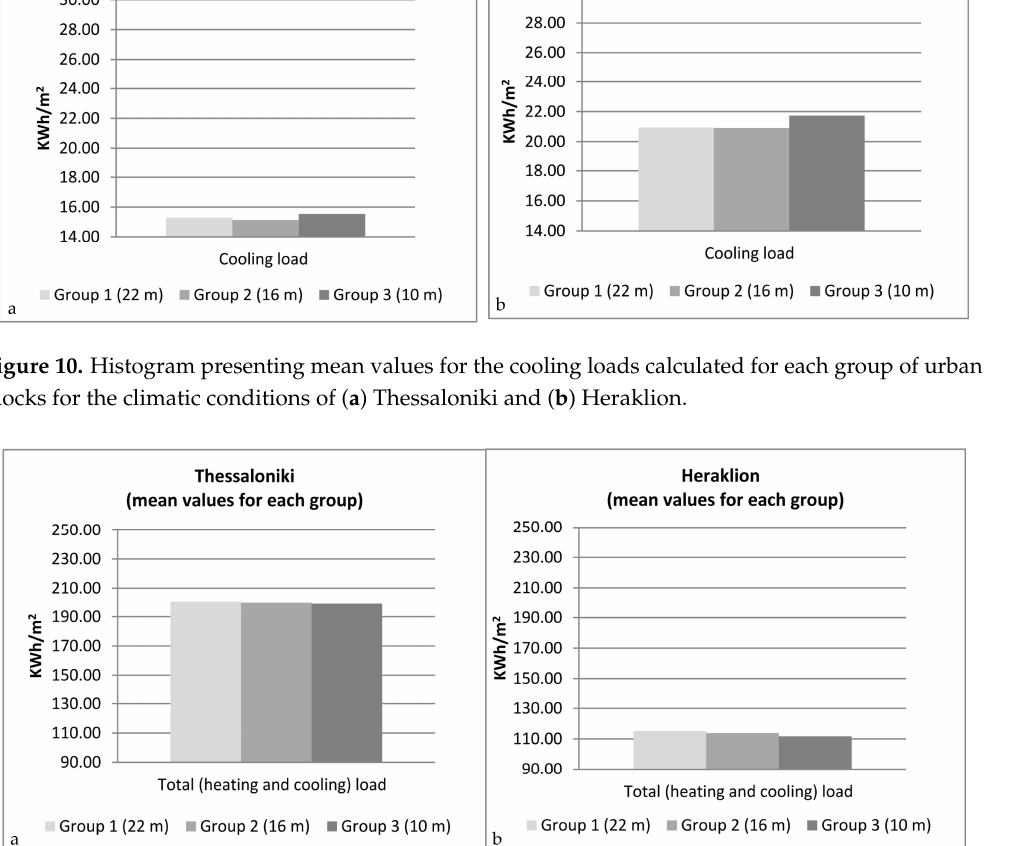
Figure 11. Histogram presenting mean values for the total loads calculated for each group of urban blocks for the climatic conditions of ( a ) Thessaloniki and ( b ) Heraklion.